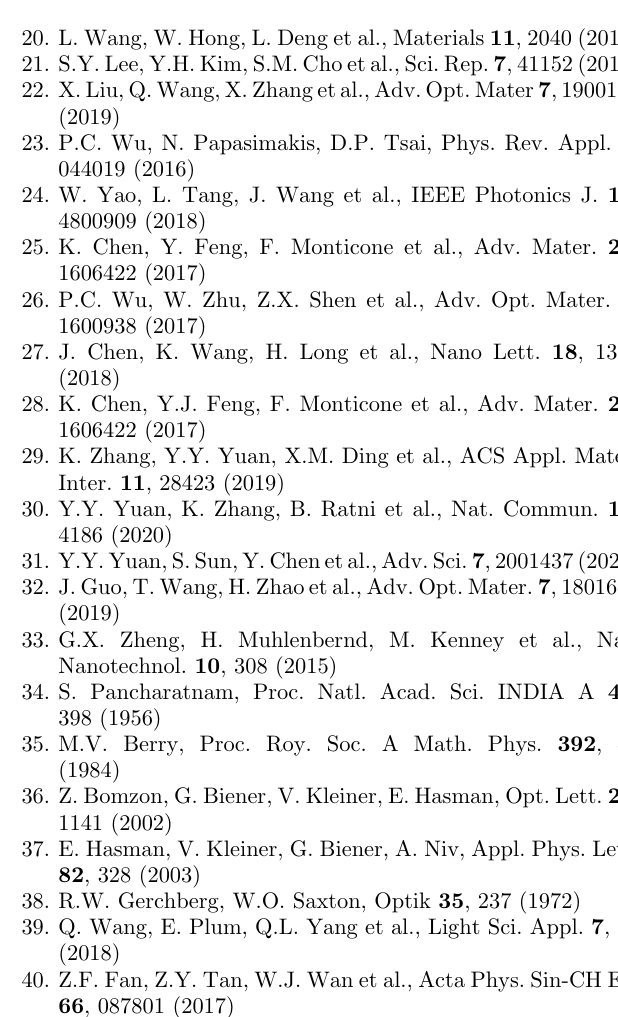
Fig. 11. Field distribution at the target plane of “ T ” , “ J ” and “ U ” obtained